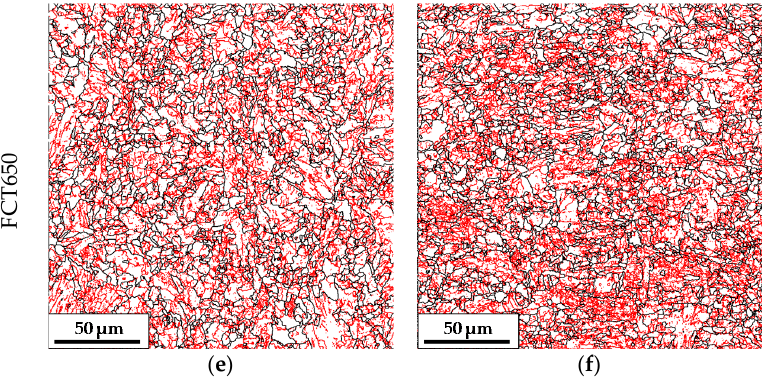
Figure 8. Grain boundary maps (red lines between 2° and 15°, black lines > 15°) corresponding to the samples obtained before (FCT in ( a , c , e )) and after induction treatment (FCT-HT in ( b , d , f )) and under different conditions: ( a , b ) FCT790 and ( c , d ) FCT720 and ( e , f ) FCT650.